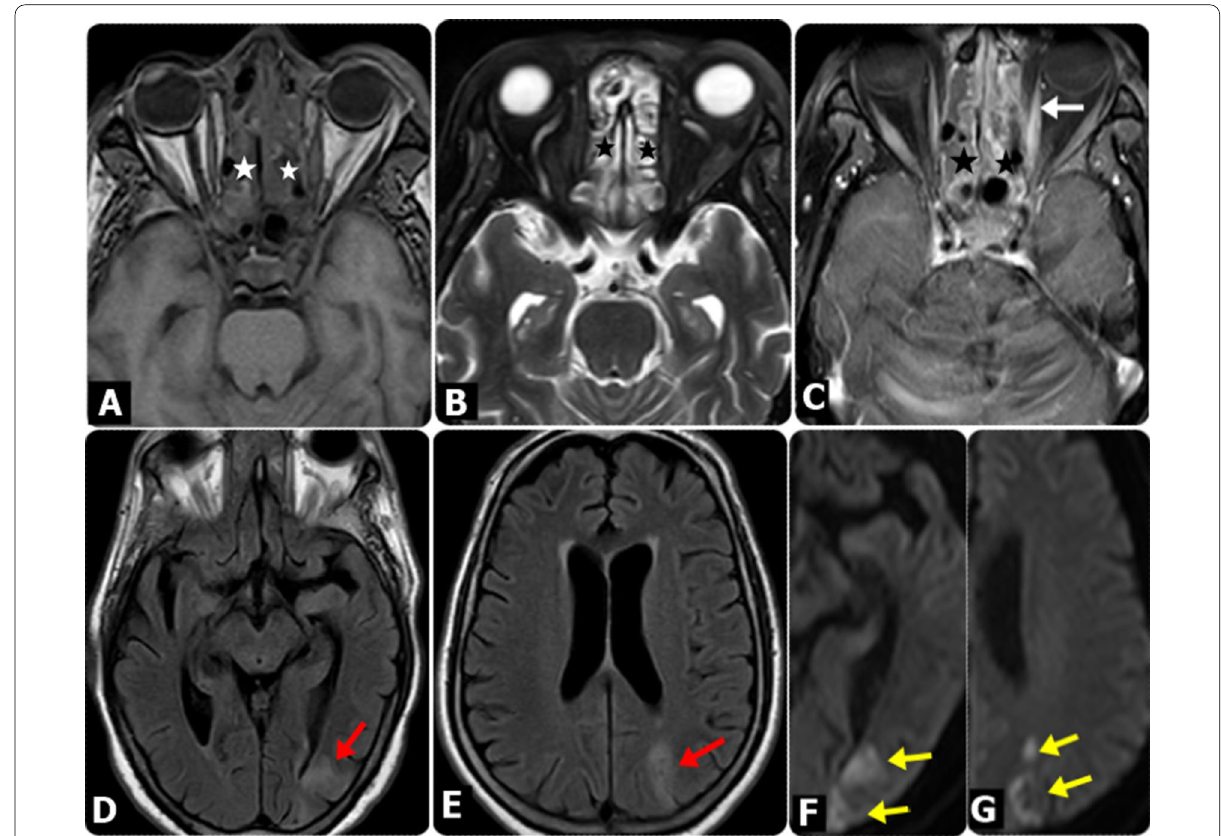
Fig. 2 MRI findings in diabetic male patient, 55 years old, presented mainly with Lt. periocular and eyelids edema, following COVID‑19. ( A ) Axial T1W, ( B ) and Axial T2 SPIR images showed bilateral ethmoidal sinusitis (Asterisks) and mild thickening of Lt. medial rectus muscle. C Axial post‑contrast fat‑saturated T1WI showed bilateral ethmoidal sinusitis with heterogeneous mucosal enhancement with mild thickened and enhanced Lt. medial rectus muscle (white arrows). D and E Axial FLAIR images; showed patchy hyperintense areas representing embolic acute infarcts at the Lt. occipital & posterior parietal regions (red arrows) which presented restricted diffusion on DW images (yellow arrows) at b‑value 1000 ( F ) and ( G